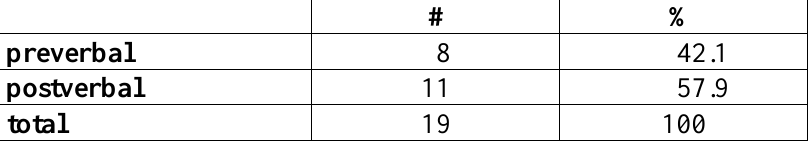
Table (5): Positioning of the overt subject in direct non-cleft non-argumental wh